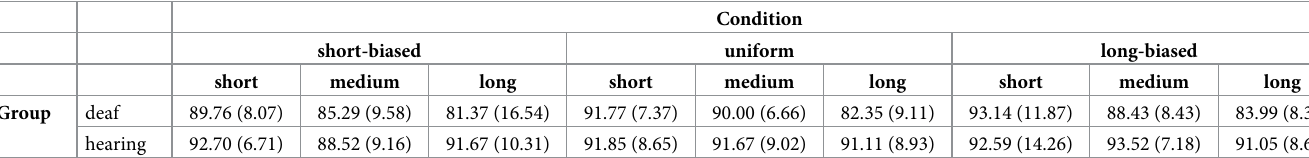
Table 6. Means and standard deviations for accuracy (i.e. percentage of not anticipated